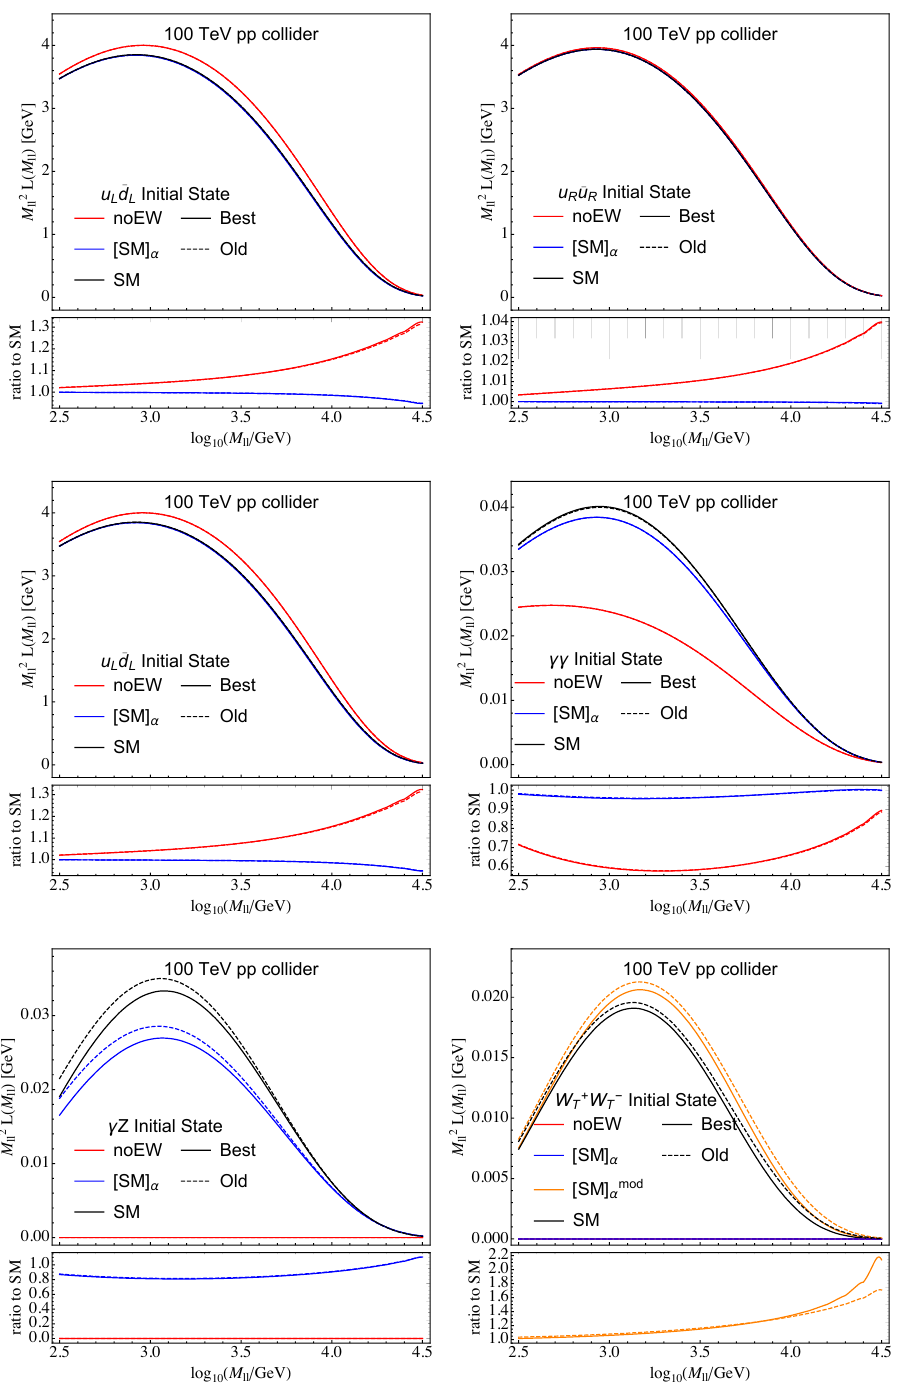
Figure 7 . Plots showing luminosities for various choices of initial states. We show in black the luminosity computed using the full SM, in red the result without any EW e(cid:11)ects, in blue the (cid:12)rst order expansion and for V T V T initial states in orange the luminosity when both (cid:12)rst order expansions are multiplied together.